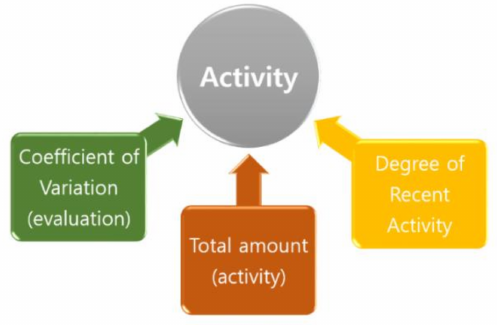
Figure 2. Elements of